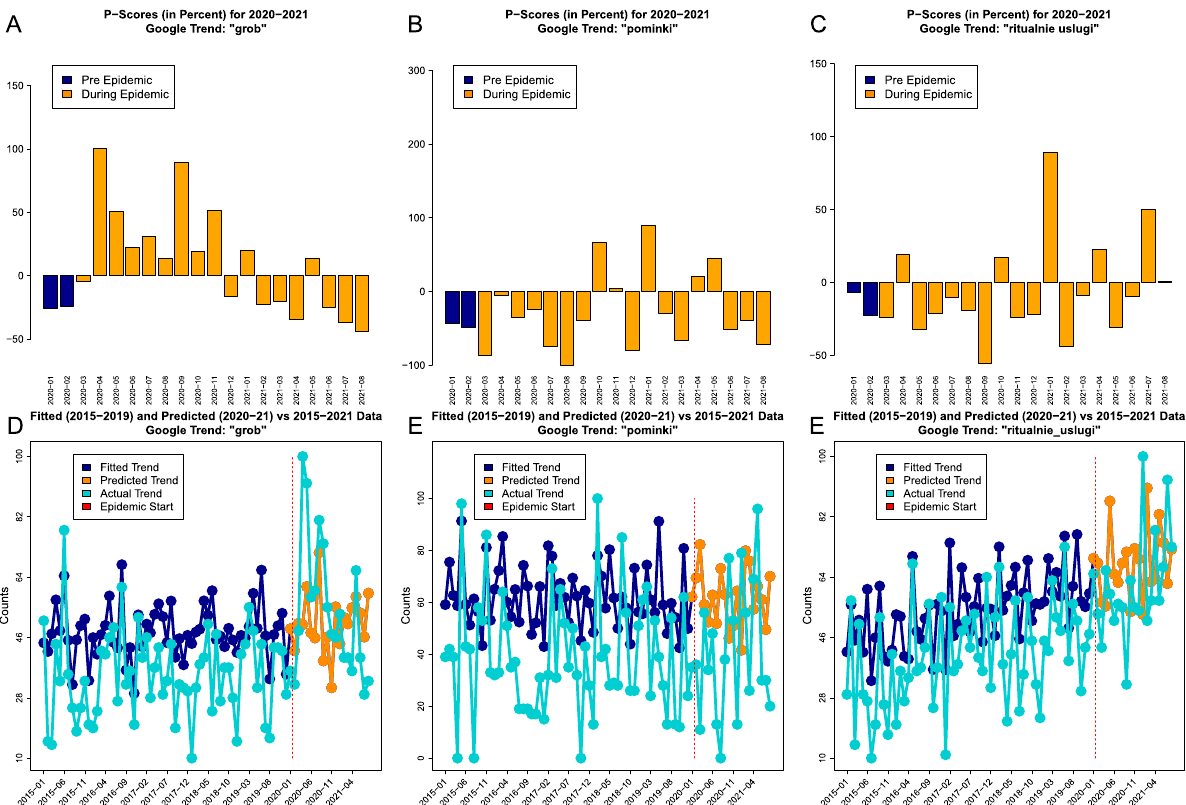
Figure 6. The visual summaries of parametric Google Trends searches P -scores are presented for the coffin (panel A ), memorial service (panel B ) and funeral services (panel C ) where orange bars are used for the epidemic period. The corresponding model predictions based on five years (dark blue) are plotted together with the queries data (cyan) for coffin (panel D ), memorial service (panel E ) and funeral services (panel E ). Vertical red bars indicate the epidemic start period.